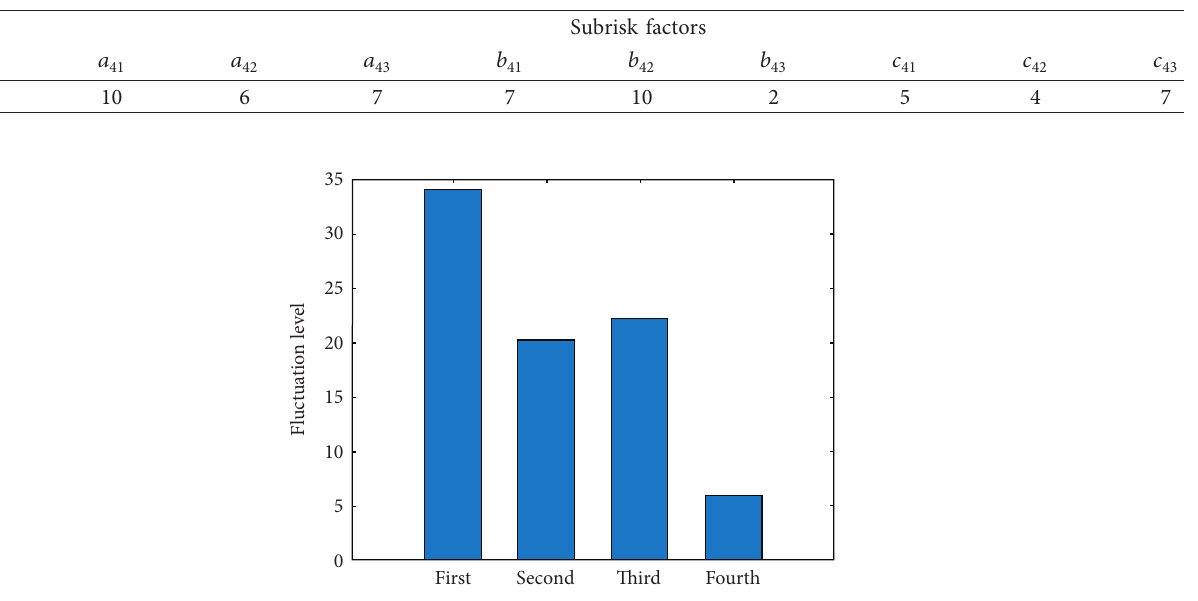
Figure 8: Total quality risk fluctuation of the first-level to the fourth-level